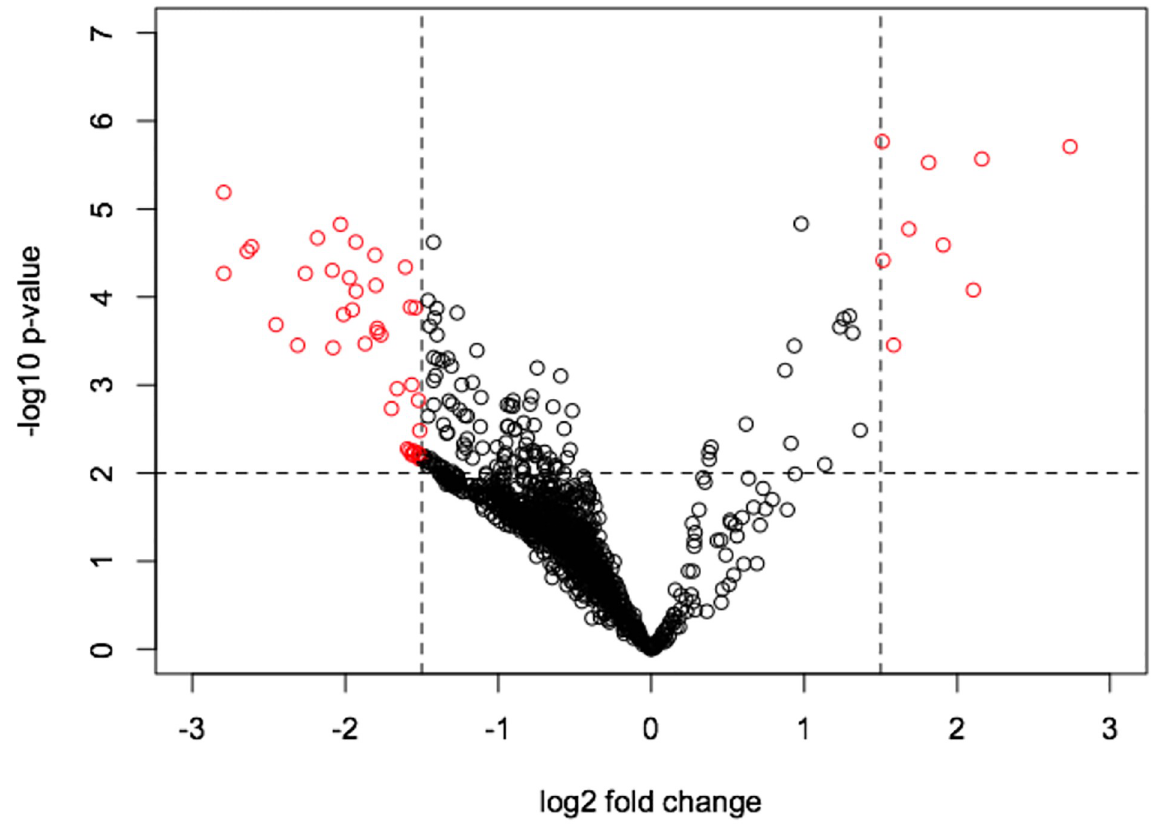
Fig 2. Volcano plot based on fold change (log 2 ) and P value ( − log 10 ) of all spectral bins of 1 H NMR urinary spectroscopy of heat-stressed (HS) vs. thermoneutral (TN) lactating dairy does. Red circles indicate the spectral bins that showed significant changes and absolute fold changes greater than